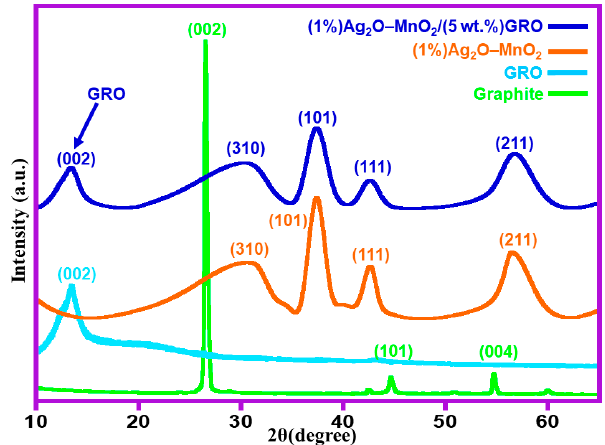
Figure 1. XRD analysis of the graphite, GRO, (1%)Ag 2 O–MnO 2 , and (1%)Ag 2 O–MnO 2 /(5 wt.%)GRO. GRO: graphene oxide.